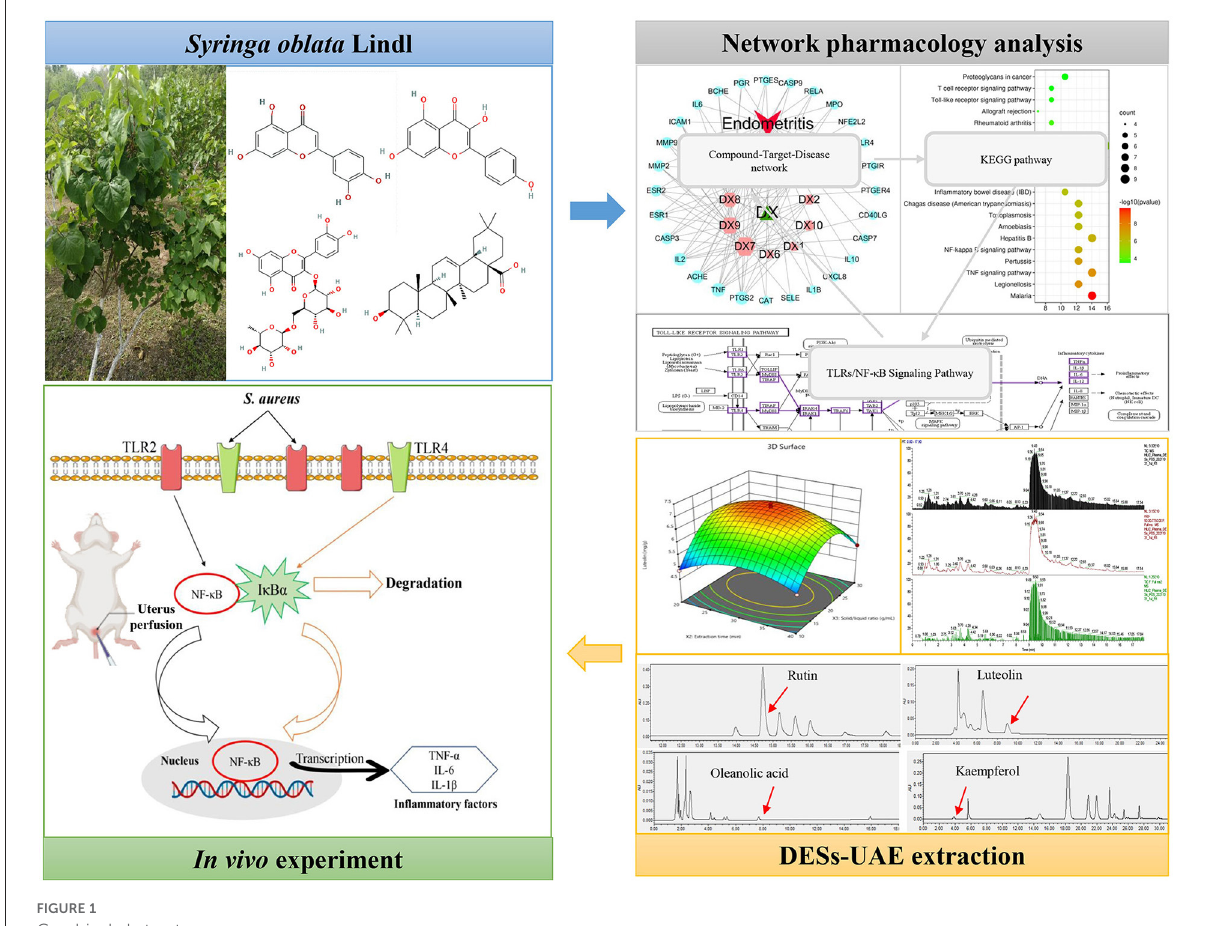
FIGURE1 Graphical